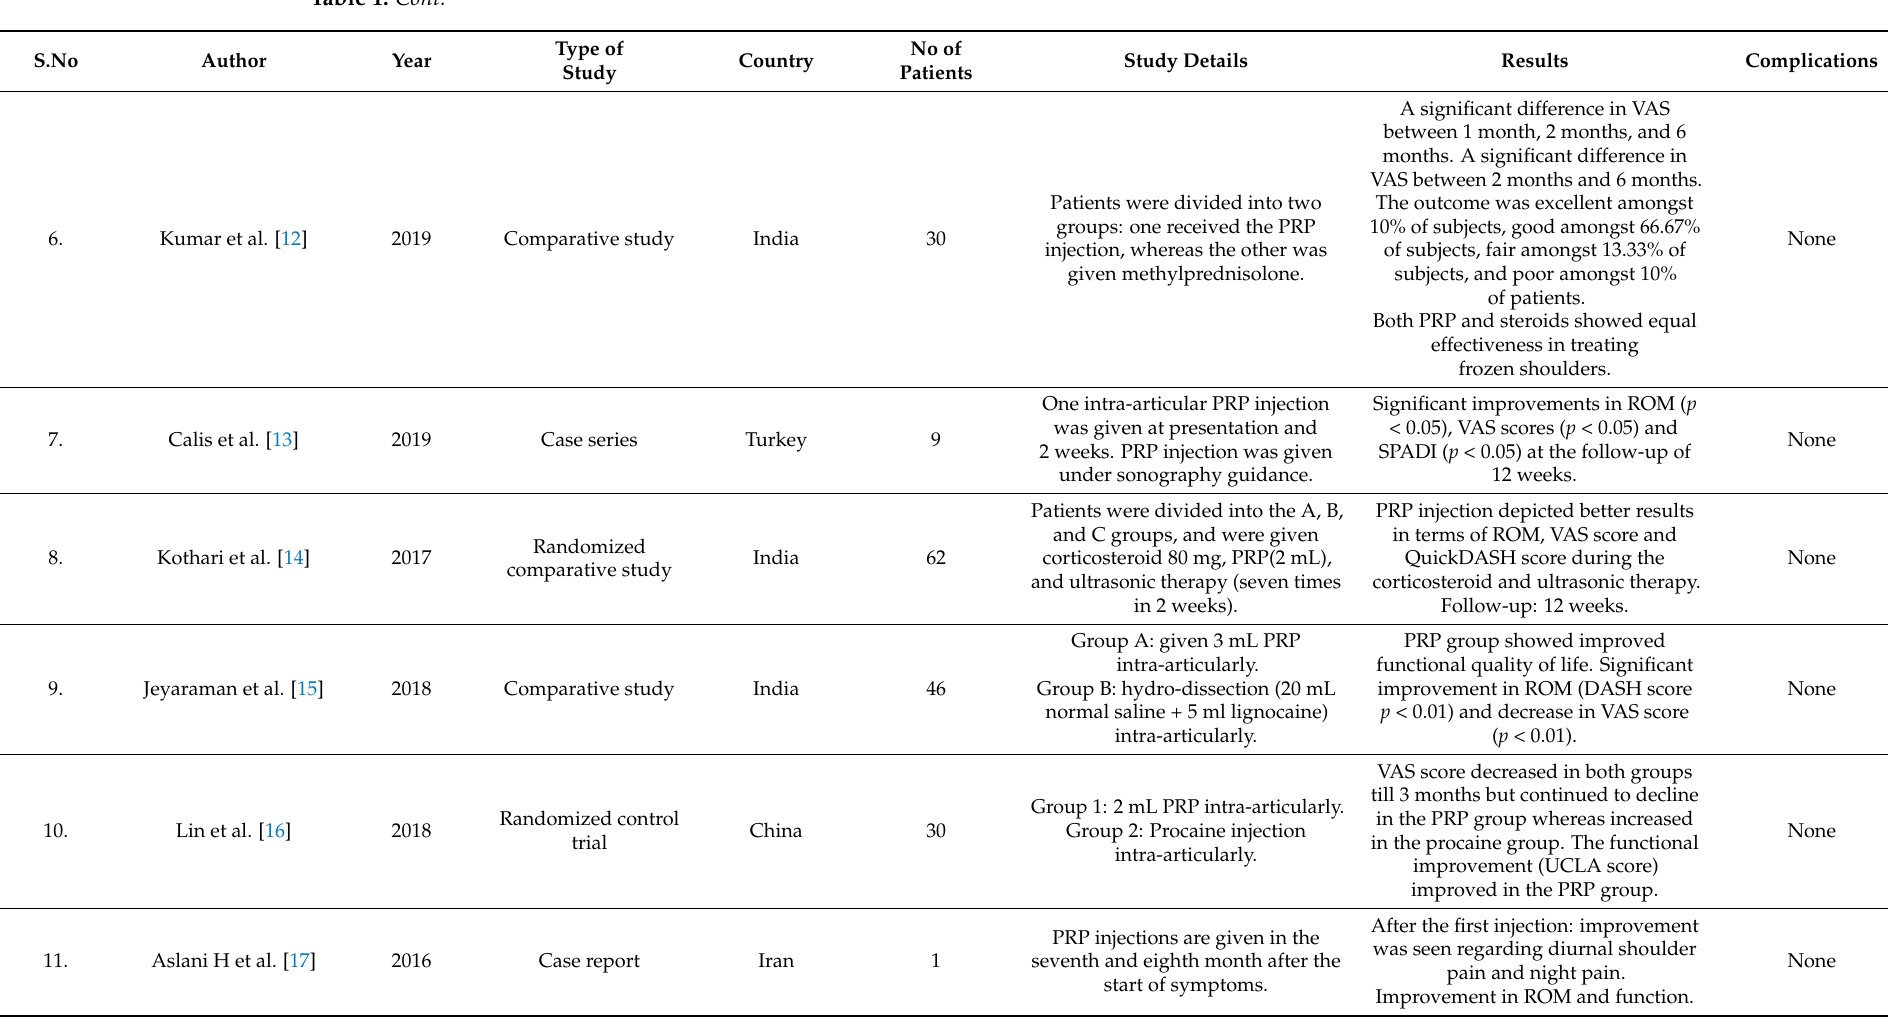
Group 1: 2 mL PRP intra-articularly. Group 2: Procaine injection